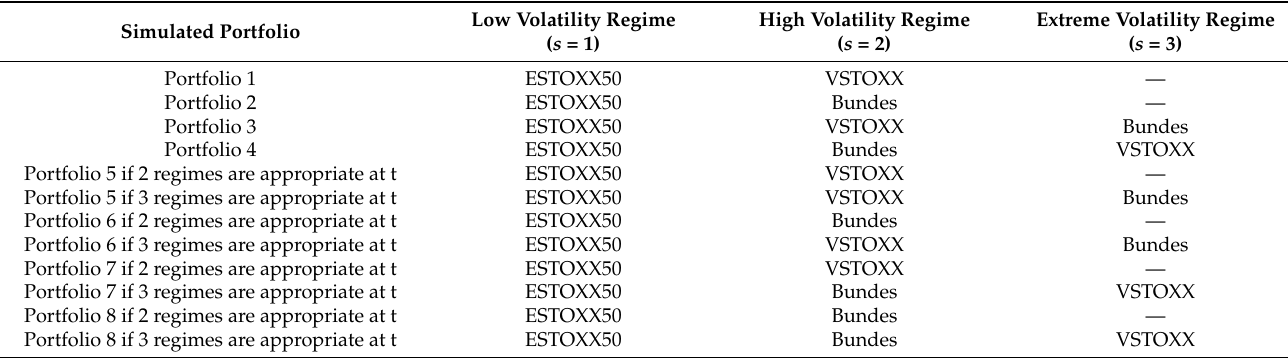
Table 2. The eight types of portfolios simulated, given the number of regimes fitted for each scenario and their corresponding security to invest, given the likelihood of being in each regime at the simulated date. Simulated